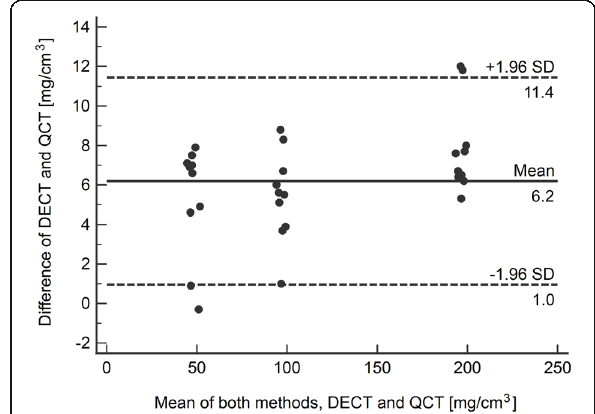
Fig. 5 Bland-Altman plot illustrating the agreement between dual- source DECT- and QCT-based BMD measurements comprising L1 (50 mg/cm 3 ), L2 (100 mg/cm 3 ), and L3 (200 mg/cm 3 ). Solid line: mean BMD difference. Dot line: 95% limits of agreement (mean difference ± 1.96 standard deviation). DECT, Dual-energy computed tomography; QCT, Quantitative computed tomography; BMD, Bone mineral density; L, Lumbar vertebra equivalent